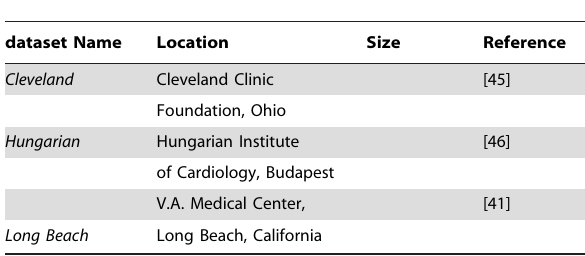
Table 2. Dataset description.